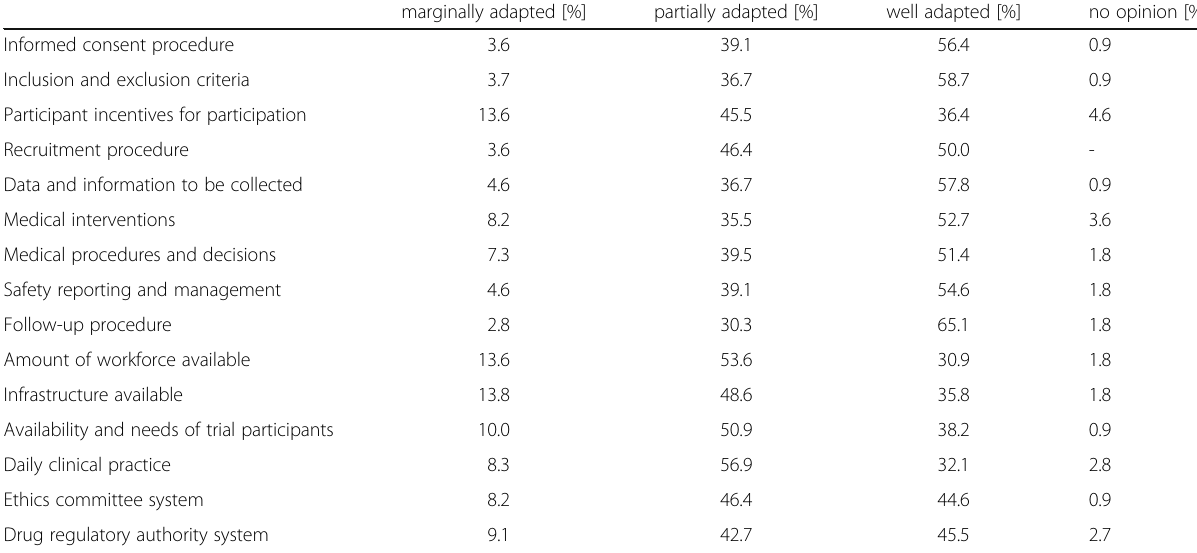
Table 6 Adaptation of protocol procedures and in-protocol required resources to the setting marginally adapted